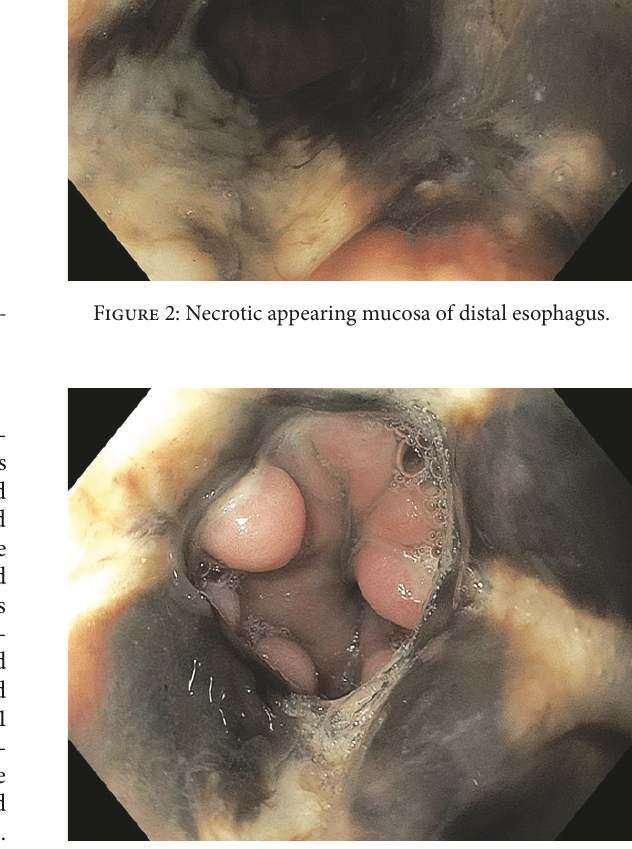
Figure 3: Necrotic appearing mucosa of distal esophagus.